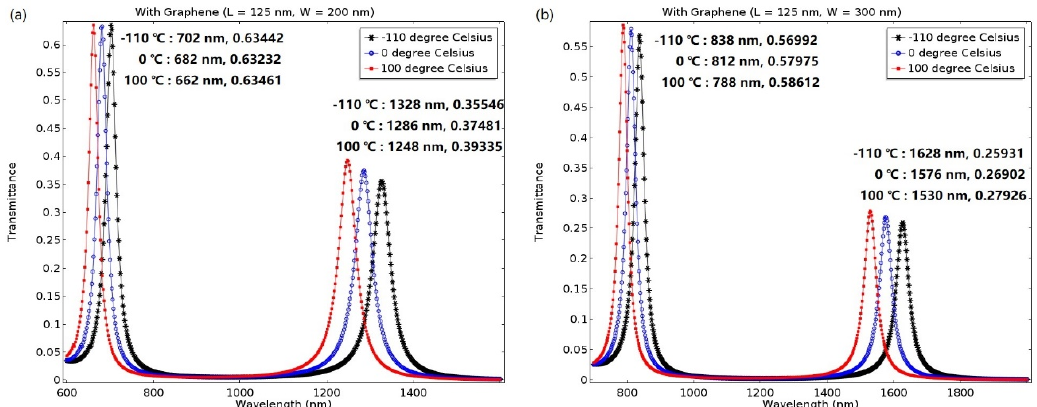
Figure 6. The transmittance of the plasmonic resonator versus different wavelengths for − 110 °C, 0 °C, and 100 °C, respectively. ( a ) At W = 200 nm, the maximum value of the transmittance is 0.63 and 0.39 in mode 1 and mode 2, respectively. ( b ) At W = 300 nm, the maximum value of the transmittance is 0.59 and 0.28 in mode 1 and mode 2, respectively.